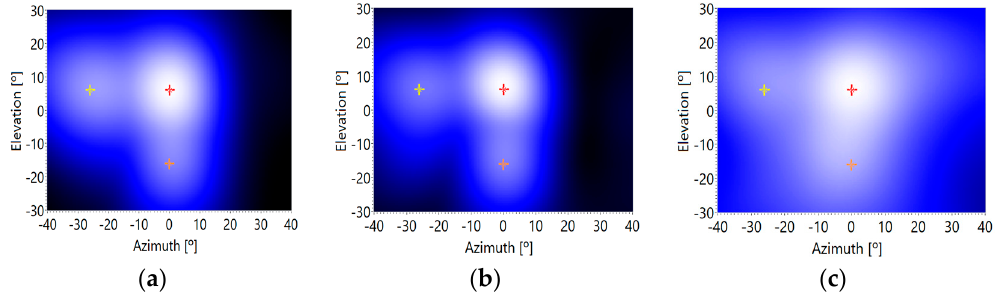
Figure 15. Time Averaged Acoustic image versus background noise levels: ( a ) minimum, ( b ) medium and ( c ) maximum.